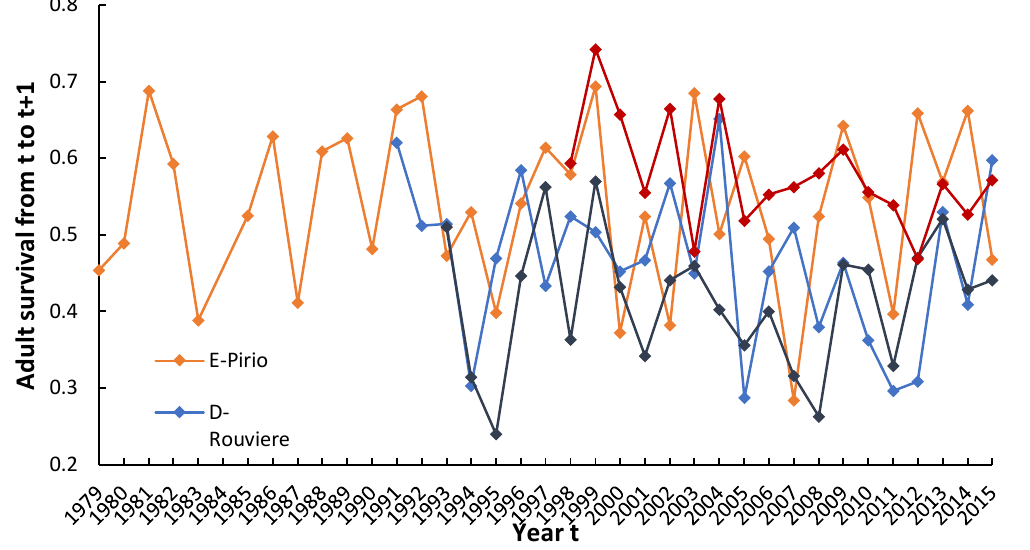
Figure 2 : Annual survival for 2+ years adults in the four focal blue tit populations between breeding events in year t and t+1, from 1979 to 2016. 95% confidence intervals are not represented for the sake of readability. Estimates are from Model 18 with φ (age + pop.year) (Table